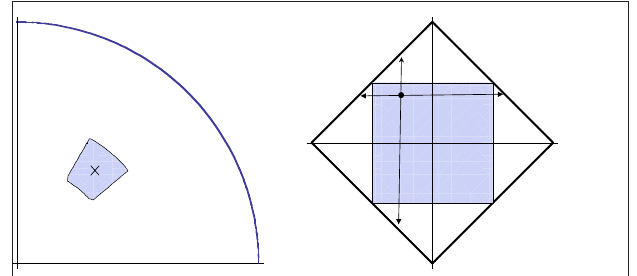
Figure 5 | Stimuli used in the location experiment (top panel) and the shape experiment (bottom). In both experiments the two observation areas Figure 6 | A detailed view of the adjustment procedure in the location are defined as “left” and “right.” The two stimuli were displayed on a flat-panel (left) and shape (right) experiments. The left-hand picture shows the first monitor viewed (using a chin rest with forehead support) from the distance of quadrant of the circle in which the location of the dot is manipulated. The cross 90 cm, making 1 screen pixel ≈ 62 sec arc. The stimuli were grayish-white on shows the location of the dot in the previous trial. Denoting its polar black, of a comfortably low fixed luminance, viewed in darkness. In the coordinates by ( θ , r ), at the beginning of the current trial the dot’s location is location experiment the stimulus values x on the left and y on the right are randomly chosen according to the uniform distribution over the rectangle locations of the dots within their circles: they are measured by the horizontal ( θ − π /18, θ + π /18) × ( r − 0.1 · radius, r + 0.1 · radius) in polar coordinates and vertical Cartesian coordinates of the dots with respect to the circles’ (shown by the colored area). The right-hand picture shows the space of the centers. The width of the circumferences and the diameter of the dots in the A , A -amplitudes, | A | + | A | ≤ R, for the shape being adjusted. At the beginning experiment were 5 px, the circles’ radii measured 70 px, and the distance 3 5 3 5 of the current trial the values of A , A (irrespective of their values in the between the circles’ centers was 150 px. The initial value of x in the 3 5 previous trial) are randomly chosen according to the uniform distribution over experiment was (27 px, 16 px), corresponding to ( π /6, 0.45 · radius) in polar the square ( − 0.5 R , 0.5 R ) × ( − 0.5 R , 0.5 R ). A participant could change the coordinates. In the shape experiment the stimulus values x on the left and y A , A -values freely within the entire diamond-shaped area, but at any given on the right are the amplitudes A and A in the formula for a “floral” shape in 3 5 3 5 ( A , A ) the rate of further change (per rotation angle of the trackball) in any of polar coordinates: R + A cos3 θ + A cos5 θ , where | A | + | A | ≤ R . In the 3 5 3 5 3 5 the four directions shown was proportional to the corresponding distances of experiment R was 70 px, the distance between the floral shapes’ centers was ( A , A ) to the borders (updating quasicontinuously and ensuring thereby that 300 px, and the width of the contours 5 px. The initial value of x in this 3 5 the boundary could never be reached). experiment was A = A = 0.2 R = 14 3 5